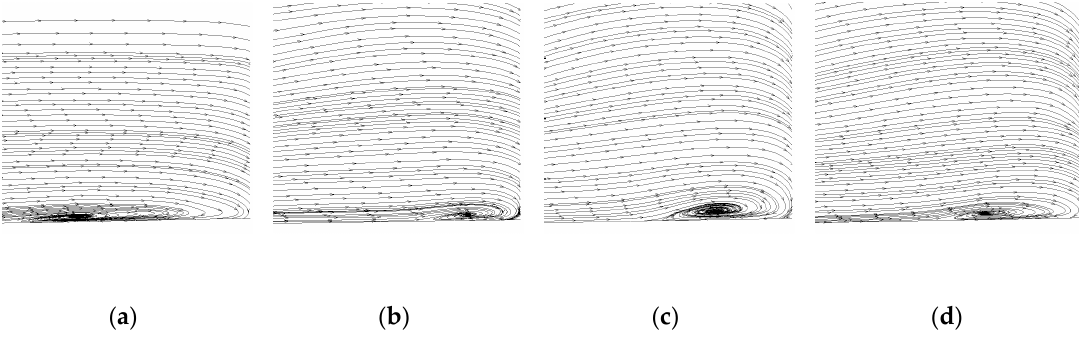
Figure 19. The streamline of Plane B between the original model and the model with triangular VGs at different distances. ( a ) The original model; ( b ) VGs at 0.1c; ( c ) VGs at 0.15c; ( d ) VGs at 0.2c.